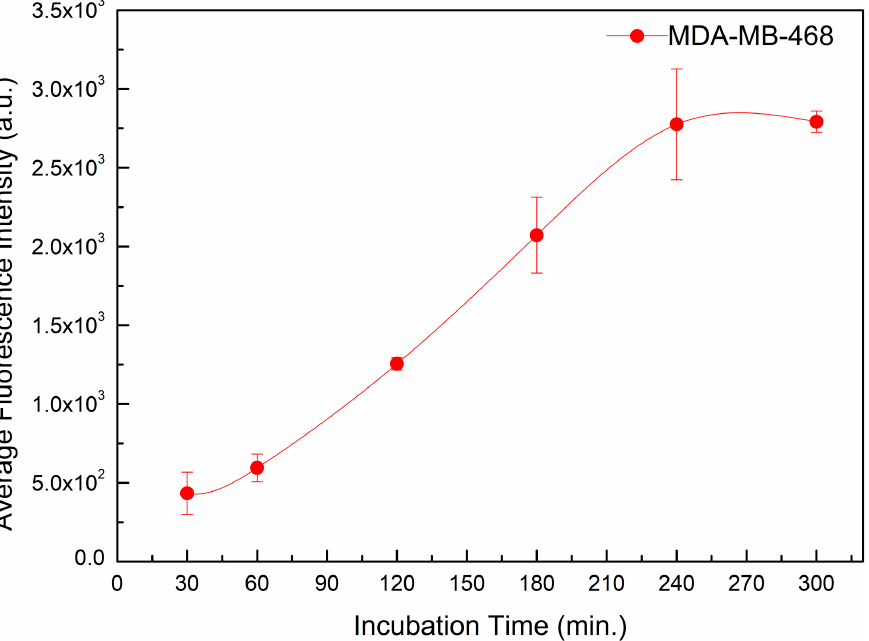
Figure 4. UV-visible spectrum of TPs and schematic representation.